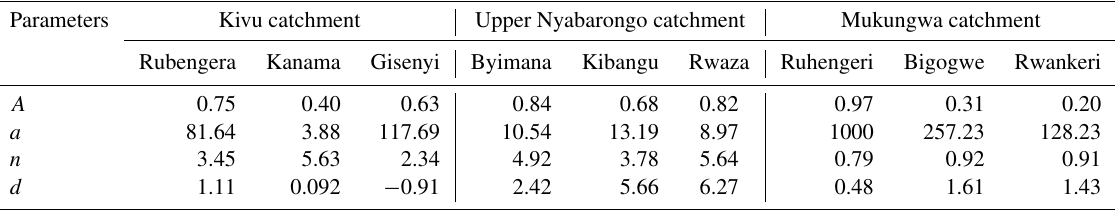
Table A1. Final values of the calibrated parameters.